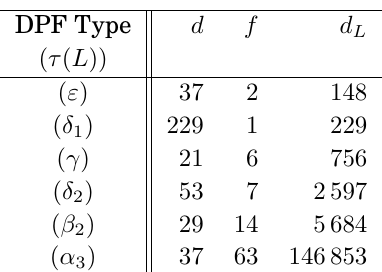
Table 28: Smallest occurrences of various